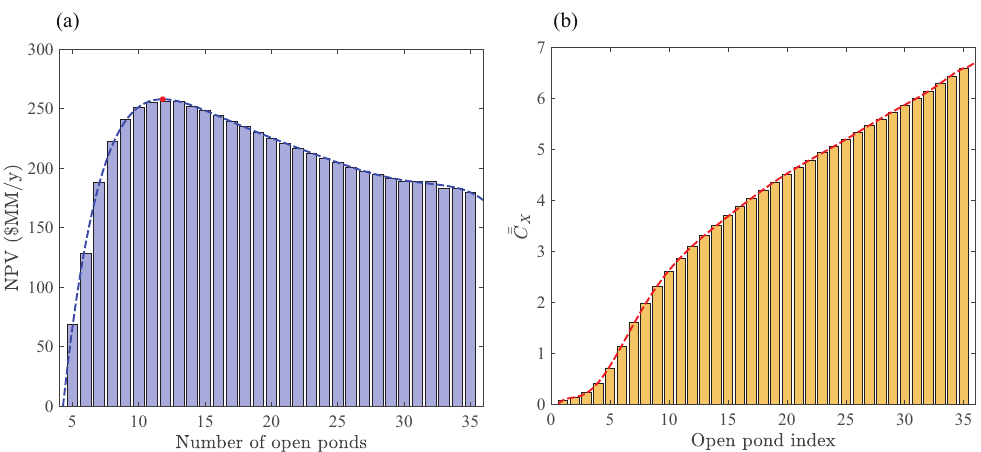
Figure 9. Optimal number of open ponds in Optimization Strategy II for the sequential-pond = 3.12 mmol/L, h = 0.651 m, and f p = 10 h. ( a ) NPV configuration (see Figure 3) operating at C CO 2 versus the number of sequential open ponds. Red circle indicates the number of ponds that furnish ( 0 ) = 0.1 g/L) distribution that the maximum NPV. ( b ) Time-averaged concentration (scaled with C X ensures the most uniform space times across all the ponds. Polynomial fits (dashed lines) are plotted to show the